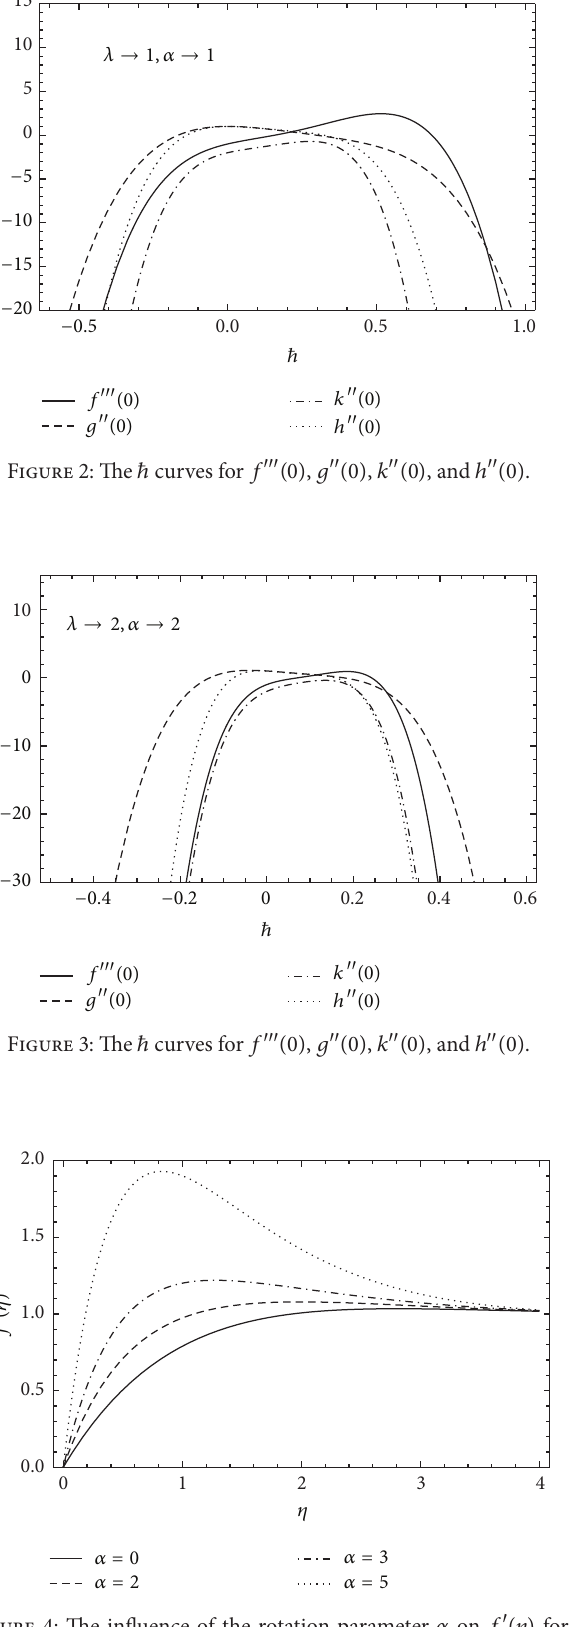
Figure 7: The influence of the couple stress parameter 𝜆 on 𝑔(𝜂) for 𝛼 = 2 , ℏ = −0.1 , and 𝜆 = 0 (Newtonian